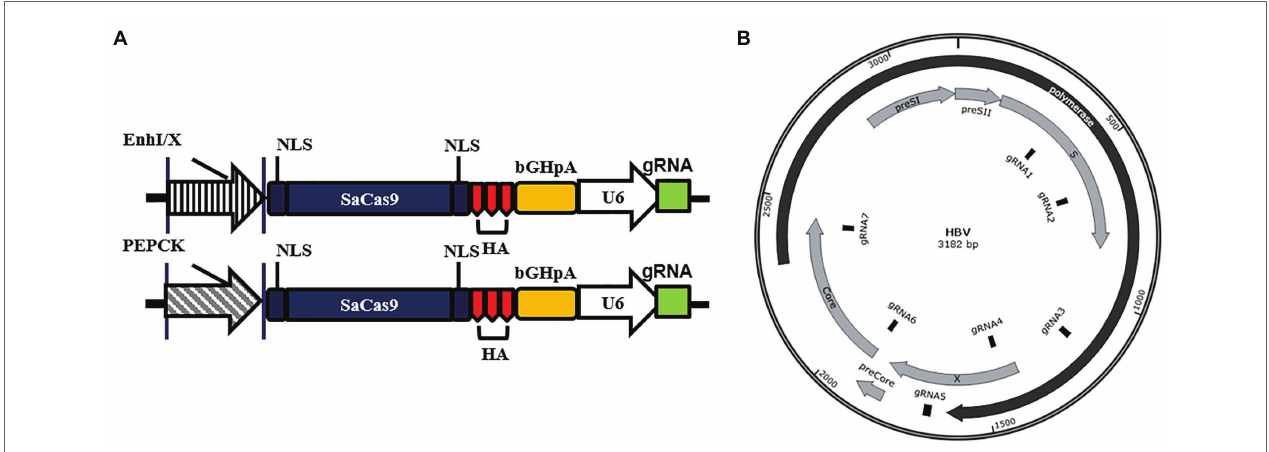
FIGURE 1 | Design of liver-specific and hepatitis B virus (HBV)-targeting CRISPR/SaCas9 system. (A) Design of the reconstructed guide RNA (gRNA)/SaCas9- expressing vector pX601-U6-HBVgRNA plasmids. NLS, nuclear localization signal; HA, HA-tag; SaCas9, human codon-optimized Staphylococcus aureus Cas9; bGHpA, bovine growth hormone poly(A) signal. (B) Schematic diagram of the gRNA-targeted sequences located in the HBV